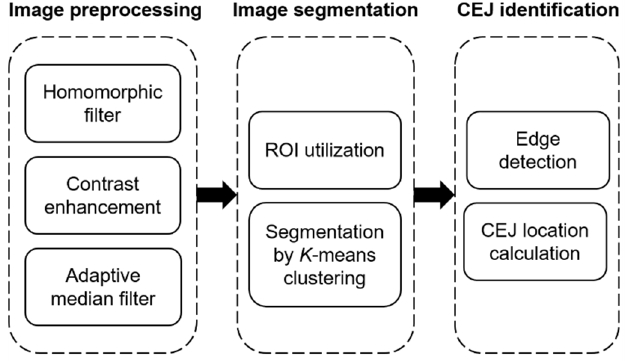
Figure 1. The image preprocessing and detection processes of the proposed method to identify CEJ.